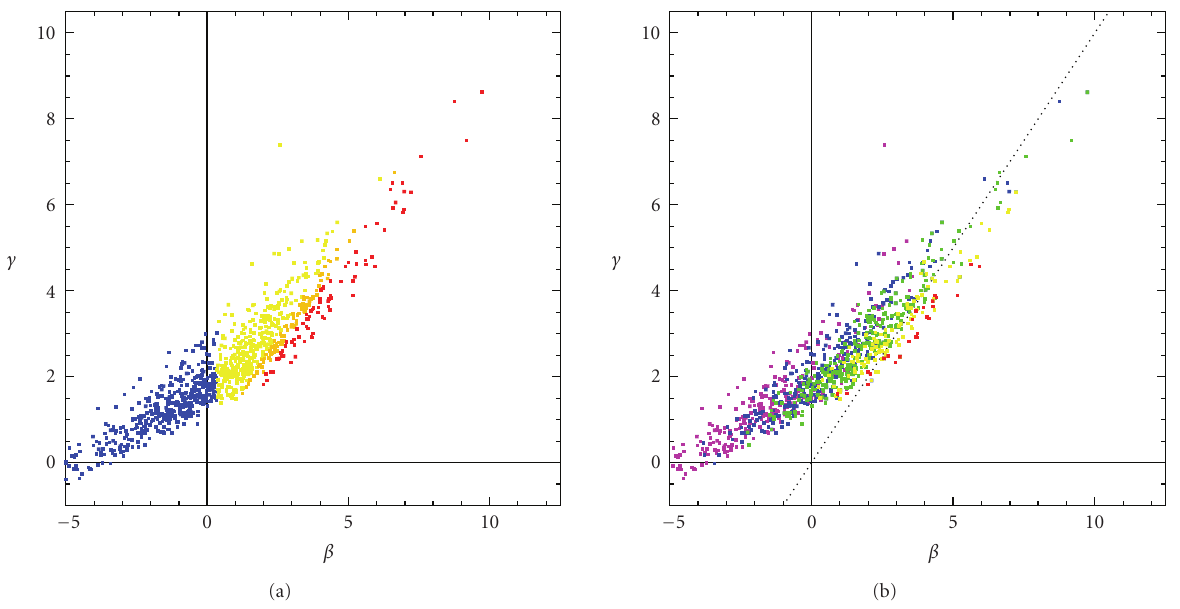
Figure 1: Distribution of parameters describing the mass accretion histories of 1000 randomly generated merger trees. (a) Colors correspond to the classes defined by McBride et al. in [18]: blue: class I, yellow: class II, orange: class III, red: class IV. (b) colors correspond to the formation redshift z 50 : magenta: z 50 < 0 . 3, blue: z 50 = 0 . 3 − 0 . 5, green: z 50 = 0 . 5 − 0 . 8, yellow: z 50 = 0 . 8 − 1 . 1, red: z 50 > 1.1. The dotted line indicates the locus of trajectories with γ − β = 0. For β (cid:2) 1, formation redshift is roughly constant along this lines parallel to this